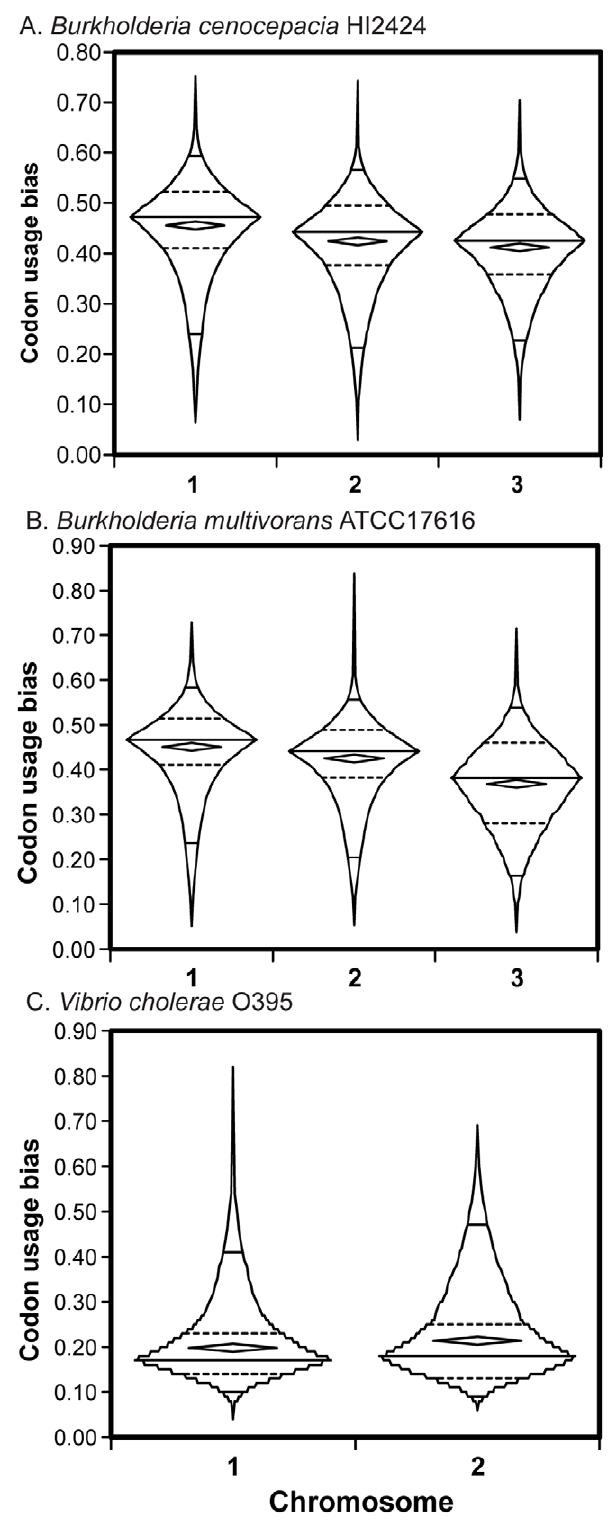
Figure 3. Distributions of synonymous codon usage bias among panorthologs by chromosome location in three repre- sentative genomes. Boxplots reflect the overall distribution of SCUO values for all genes on each chromosome; interior diamonds represent the means. All pairwise comparisons are statistically significant (Table 1).